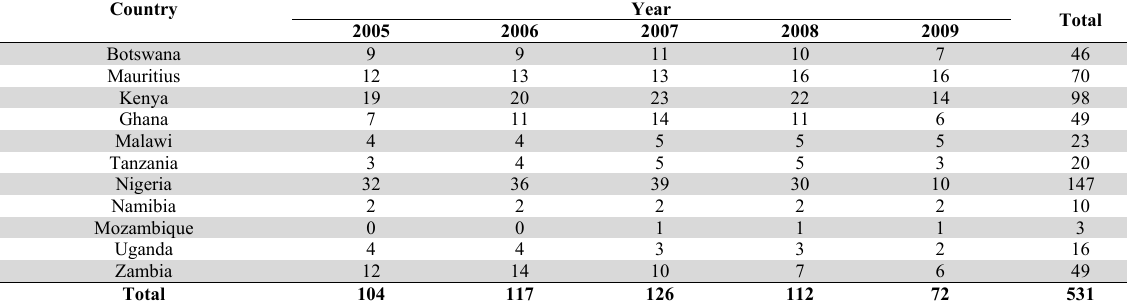
Sample Distribution by country and